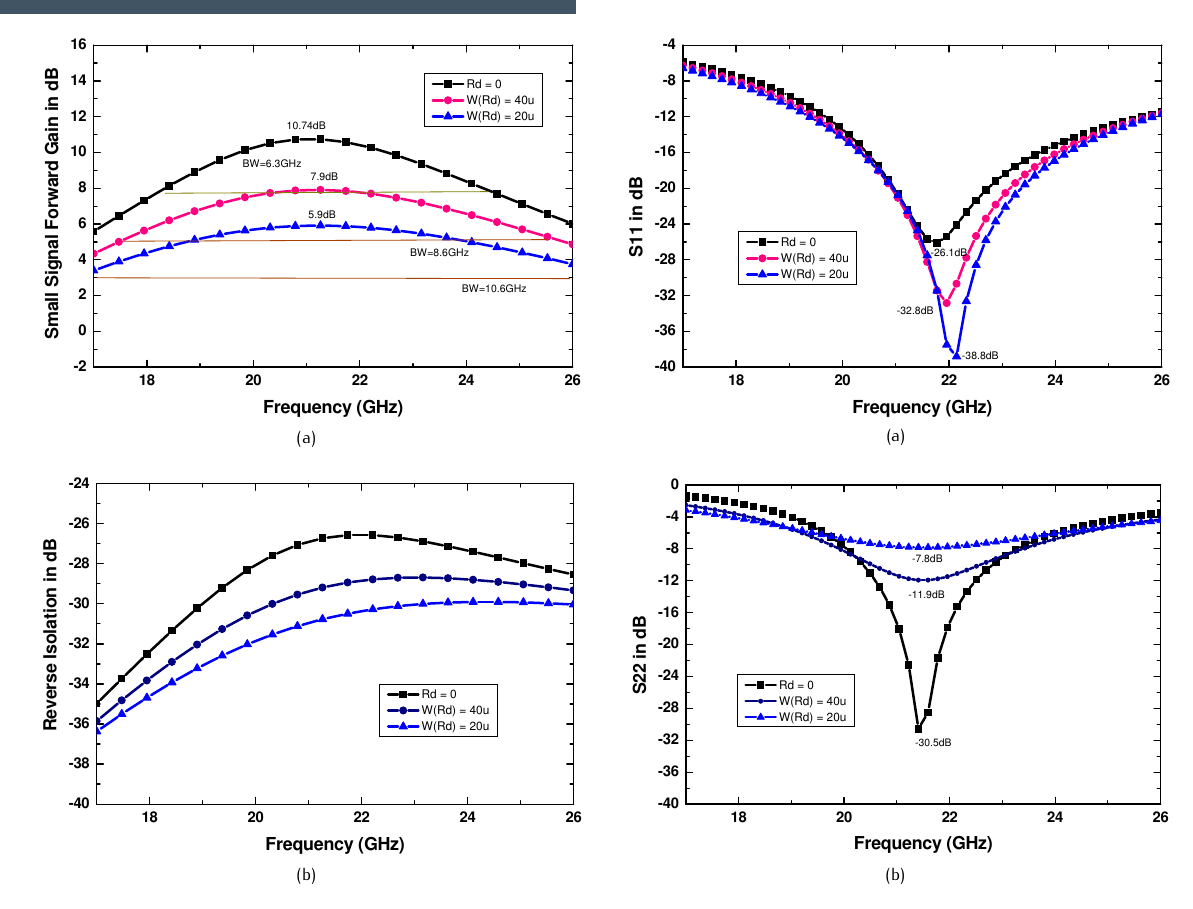
Figure 5. Effect of regulation on gain and bandwidth (as shown by a) S 21 and b) S 12 ).